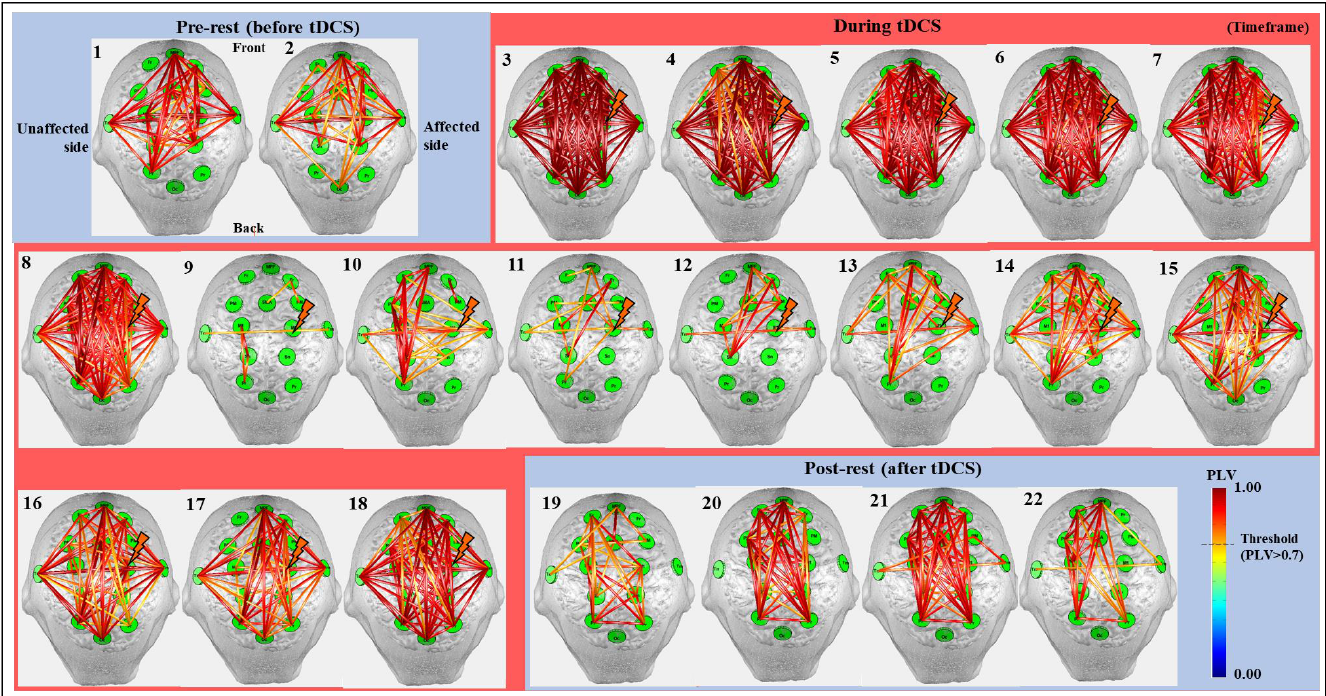
Figure 3. The cortical synchrony results analyzed by using the OptoNet II ® software based on the total 22 timeframes in all 26 subjects. The green circles — functional brain regions, the colored lines — the synchrony connections, the lightning mark — the tDCS target.